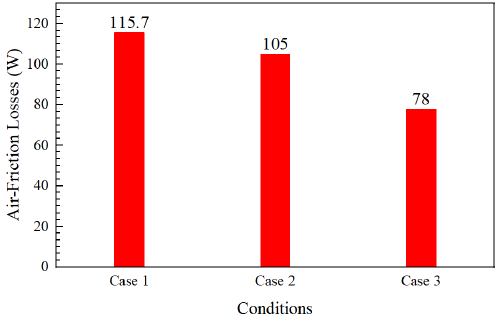
Figure 17. Air ‐ friction losses in the three cases at rated speed.